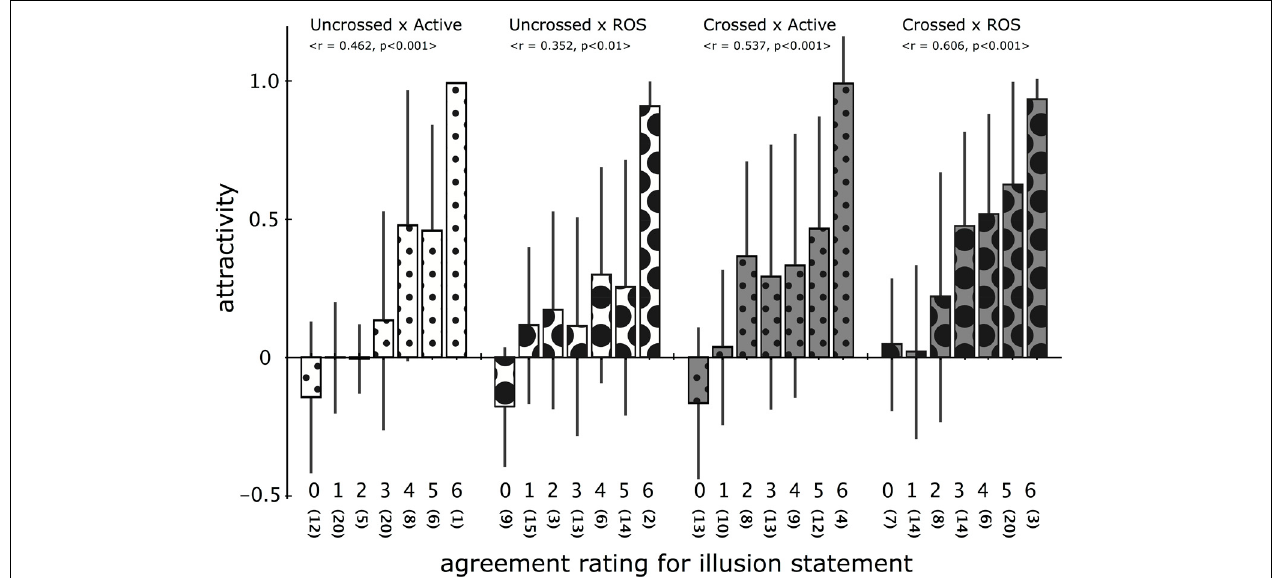
FIGURE 7 | Relationship between agreement rating for illusion statement and average attractivity in four types of hand postures. Each average of attractivity was calculated from all sessions involving the same agreement rating (0–6) for the illusion